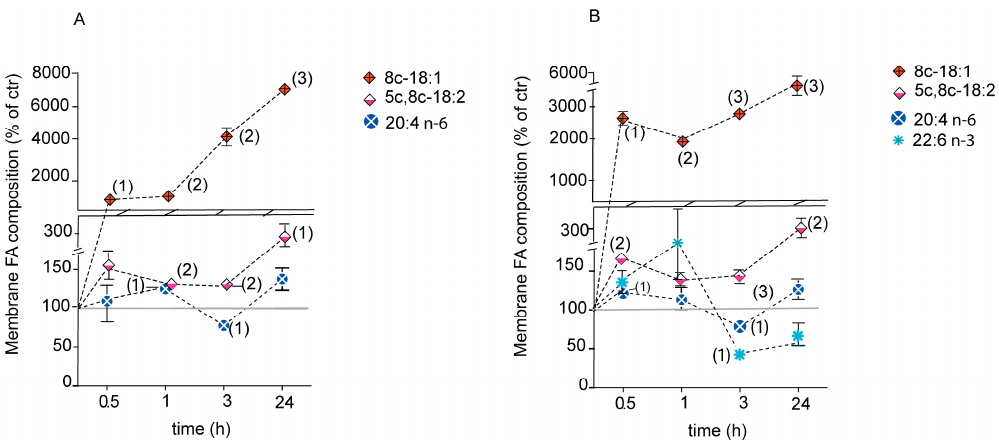
Figure 4. Time monitoring of significant MUFA and PUFA changes in membrane fatty acids of Caco-2 cells (reported as % of controls) treated with sapienic acid. ( A ) 150 µ M and ( B ) 300 µ M. The corresponding quantitative values are reported in Supplementary Information (Tables S3, S4 and S7). The grey bar indicates the values of control cells. Numbers in parenthesis indicate the statistical significance value: (1) p ≤ 0.047; (2) p ≤ 0.0097; (3) p ≤ 0.0009 for ( A ); (1) p ≤ 0.0485, (2) p ≤ 0.0073, (3) p ≤ 0.0009 for ( B ).